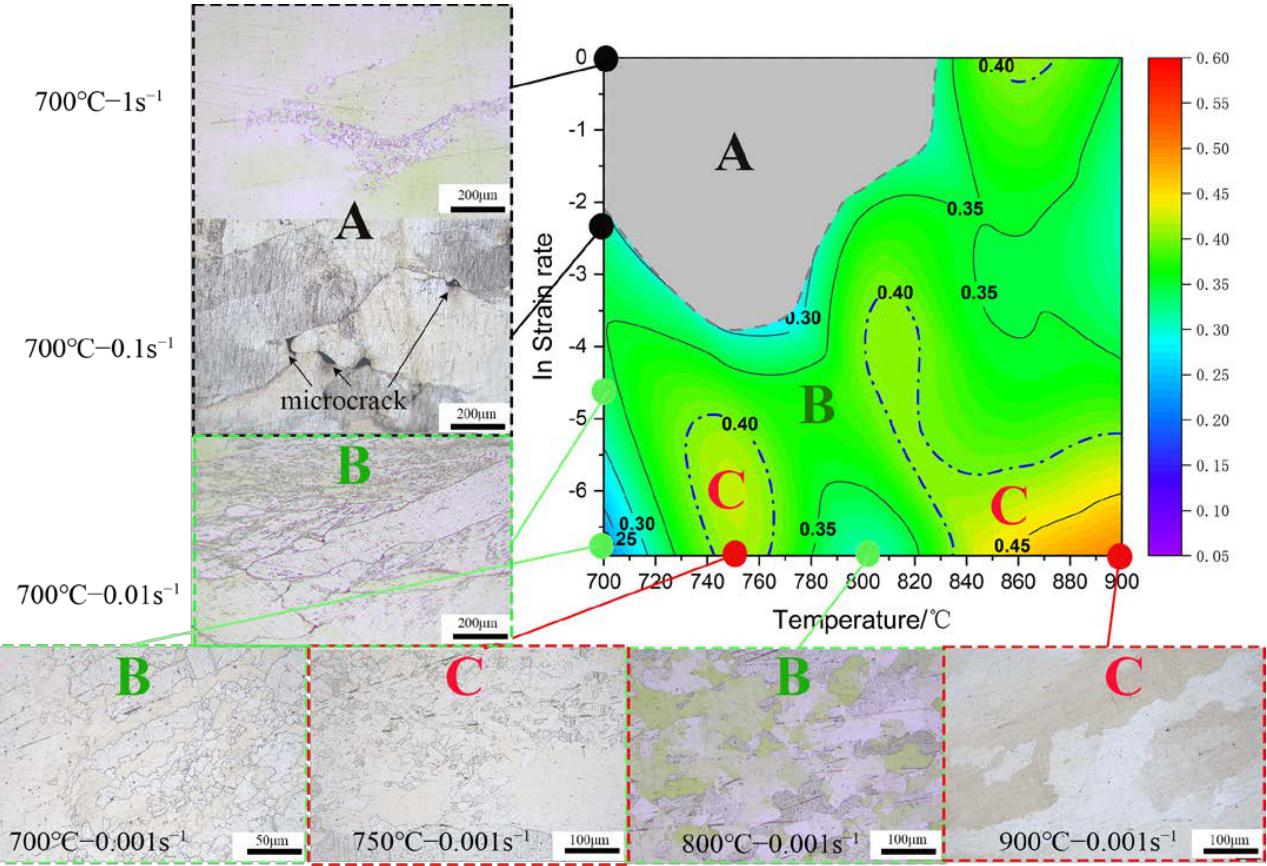
Figure 9. Hot processing map and OM of the Cu − 9Ni − 6Sn alloy after hot compression with a true strain of 0.9.